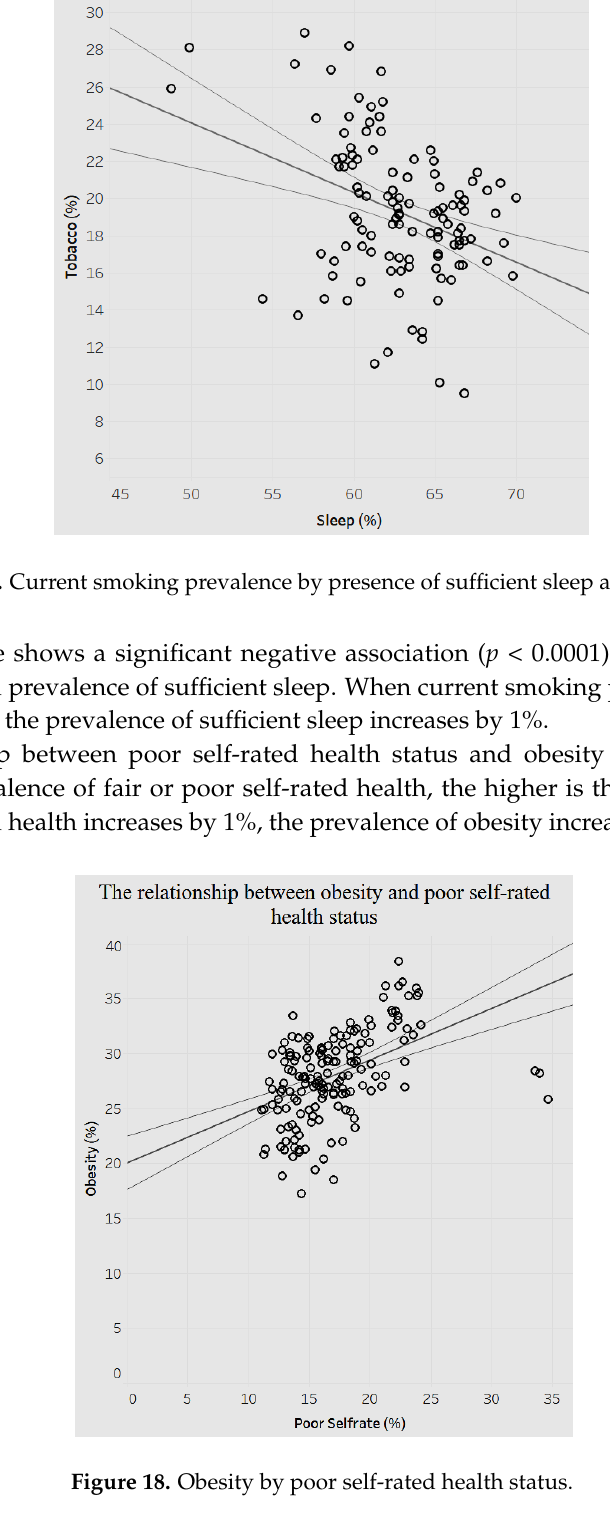
Figure 18. Obesity by poor self-rated health status.